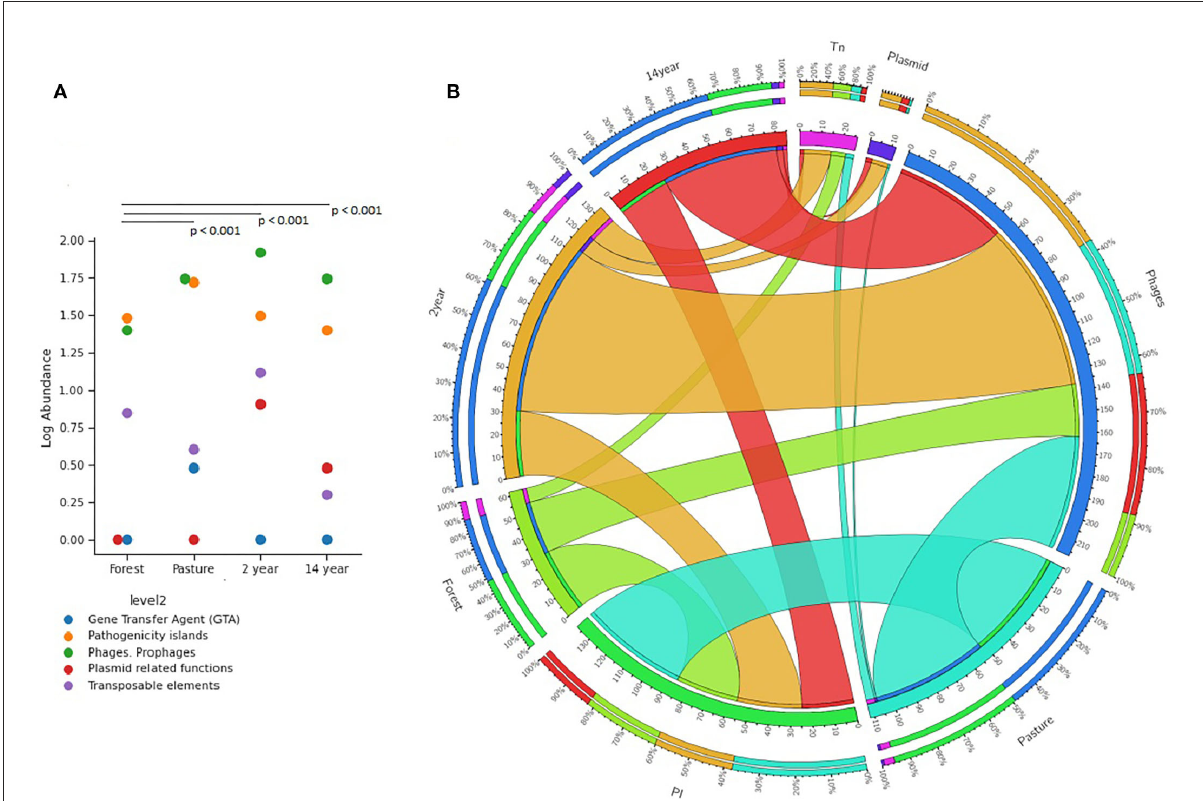
FIGURE3 Distribution of the relative abundance of genes identified from the SUB Systems database of the MG-RAST platform for gene transfer agents (GTA), pathogenicity islands (PI), phages and prophages, plasmids, and transposons (Tn); (A) distribution in the different soils, the p -values obtained from Mann–Witney were corrected by Bonferroni analysis; (B) graphic representation of this distribution in circles.